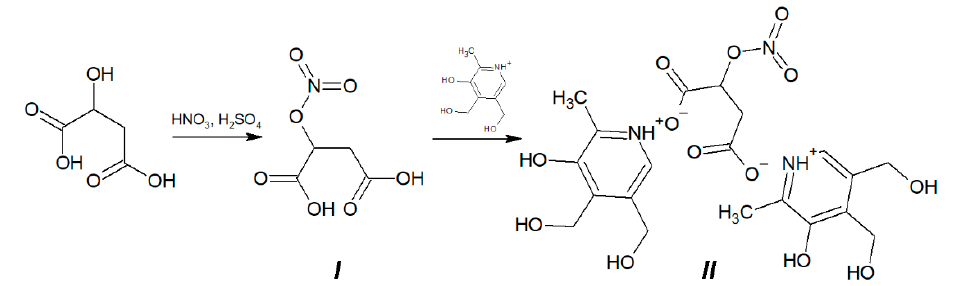
Figure 1. Synthesis of di(3-hydroxy-4,5-bis(hydroxymethyl)-2-methylpyridinium) salt of